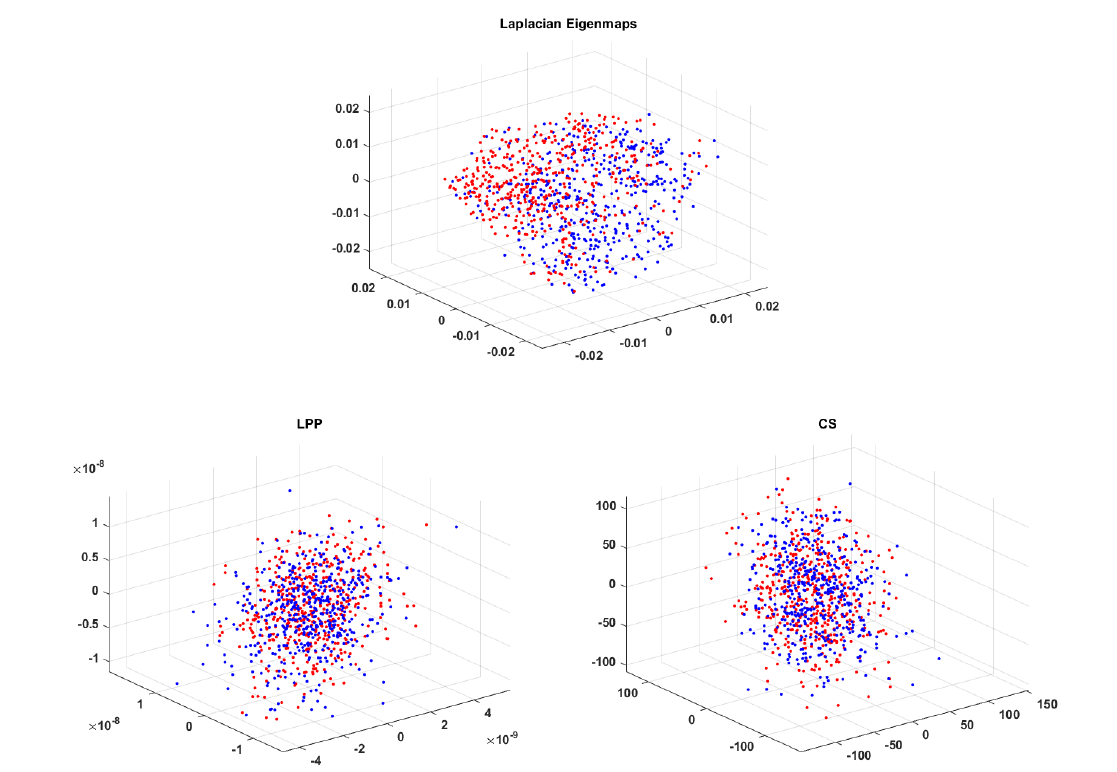
Figure 14. EEG data mapped into a 3-dimensional space with LE, LPP and CS